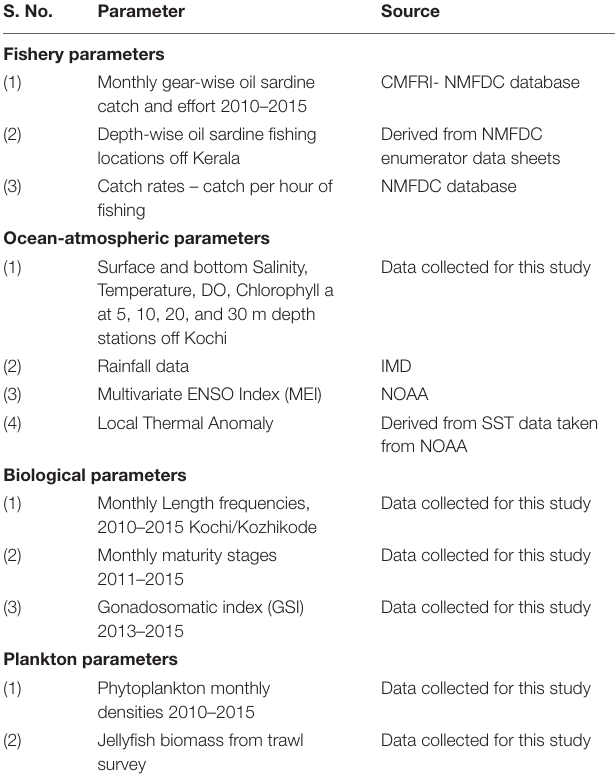
TABLE 1 | Type and source of data used in the